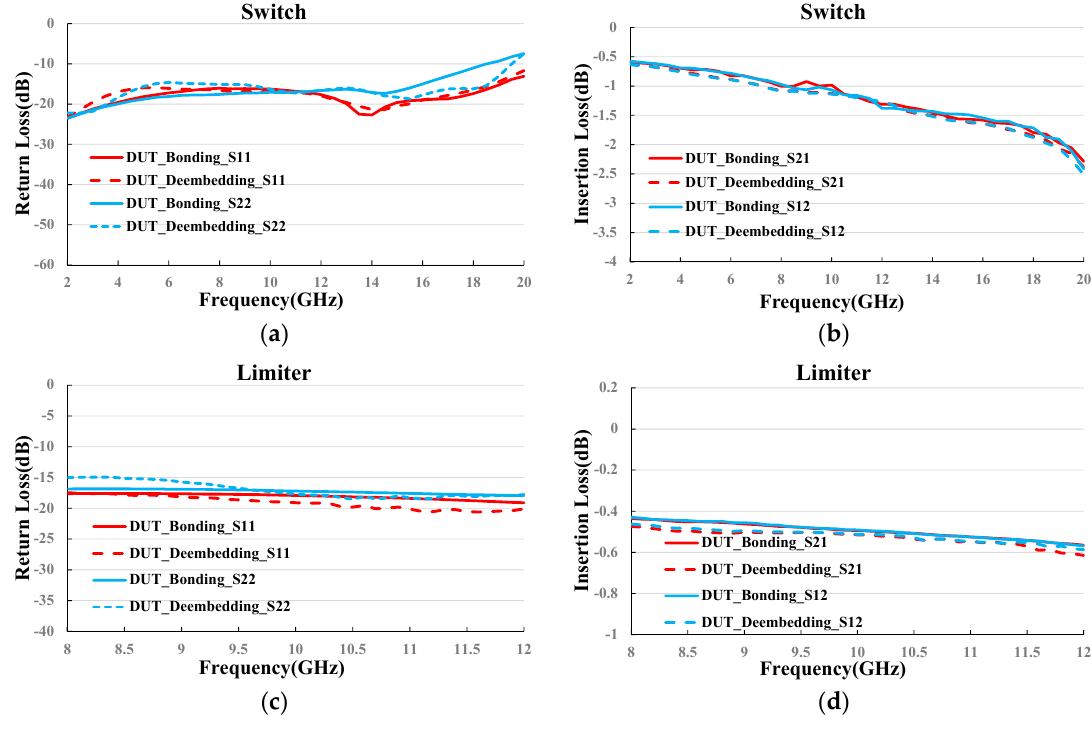
Figure 13. Comparison of the S ‐ parameters measurement results between different methods, with ( a , b ) corresponding to return loss and insertion loss of switch, ( c , d ) corresponding to return loss and insertion loss of limiter.